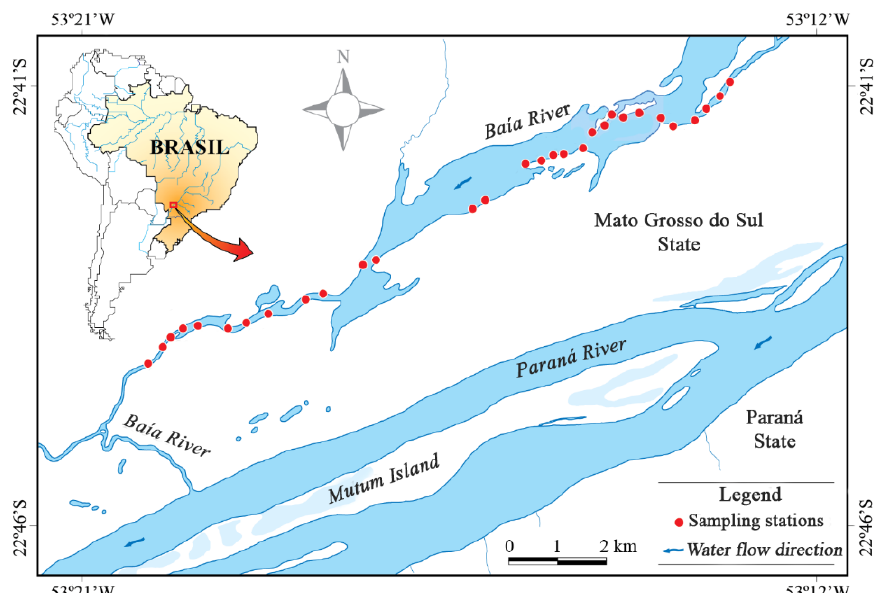
Figure 1. Map of the study area showing the sites (red points) where macrophyte stands were sampled in the Baía River (river − floodplain system of the Upper Paraná River, Brazil). EPSG: 4618.